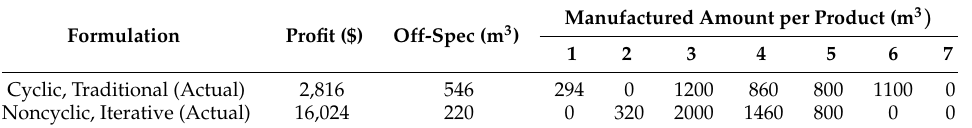
Table 25. Economic results: Scenario 4.